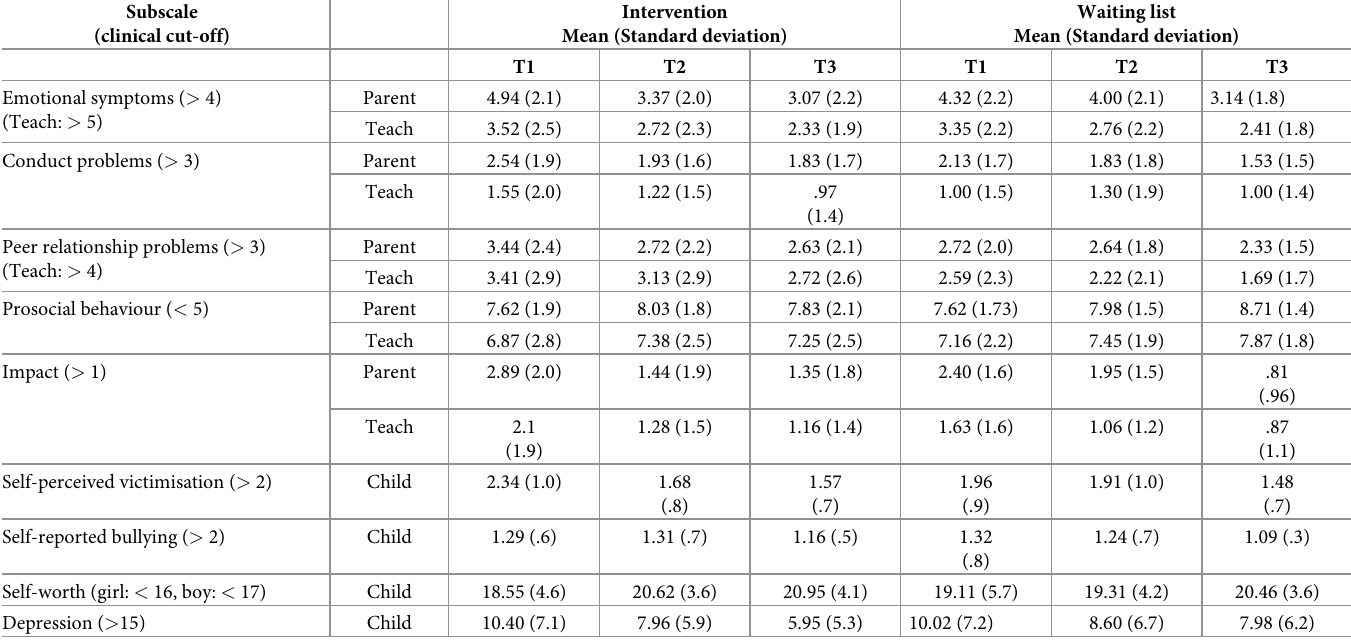
Table 2. Means and standard deviations (between brackets) for the intervention and waiting list group at T1, T2, and T3 (with clinical cut-offs of each subscale between brackets). Subscale (clinical cut-off)